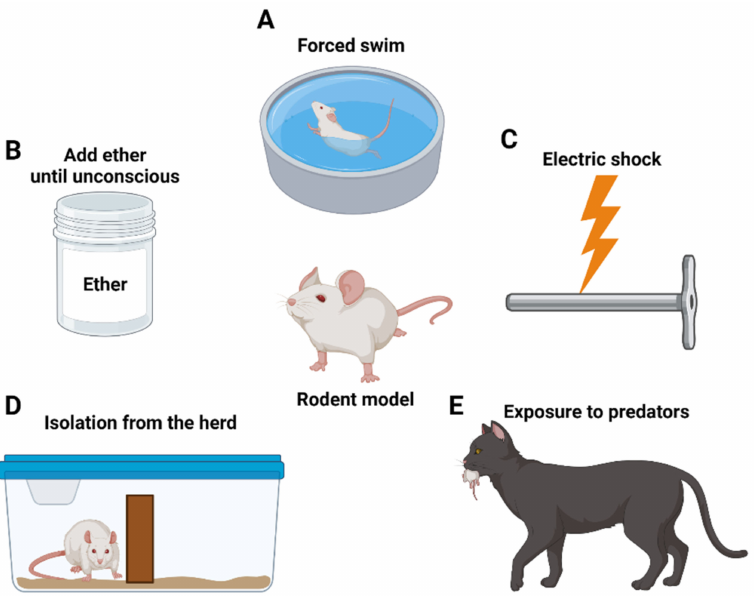
Figure 1. Development of PTSD animal models. ( A ) Forced swimming; ( B ) ether is applied to the rodent model until it becomes unconscious; ( C ) electric shock through metal bar; ( D ) isolation from the parent herd; and ( E ) exposure to